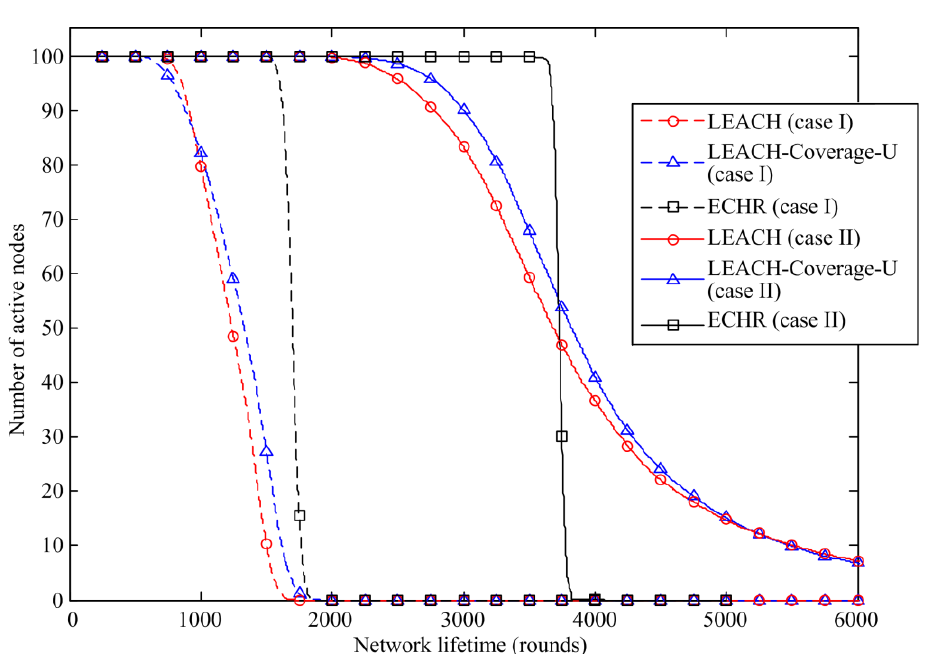
Figure 8. Comparison of the active nodes of the proposed ECHR protocol with those of other